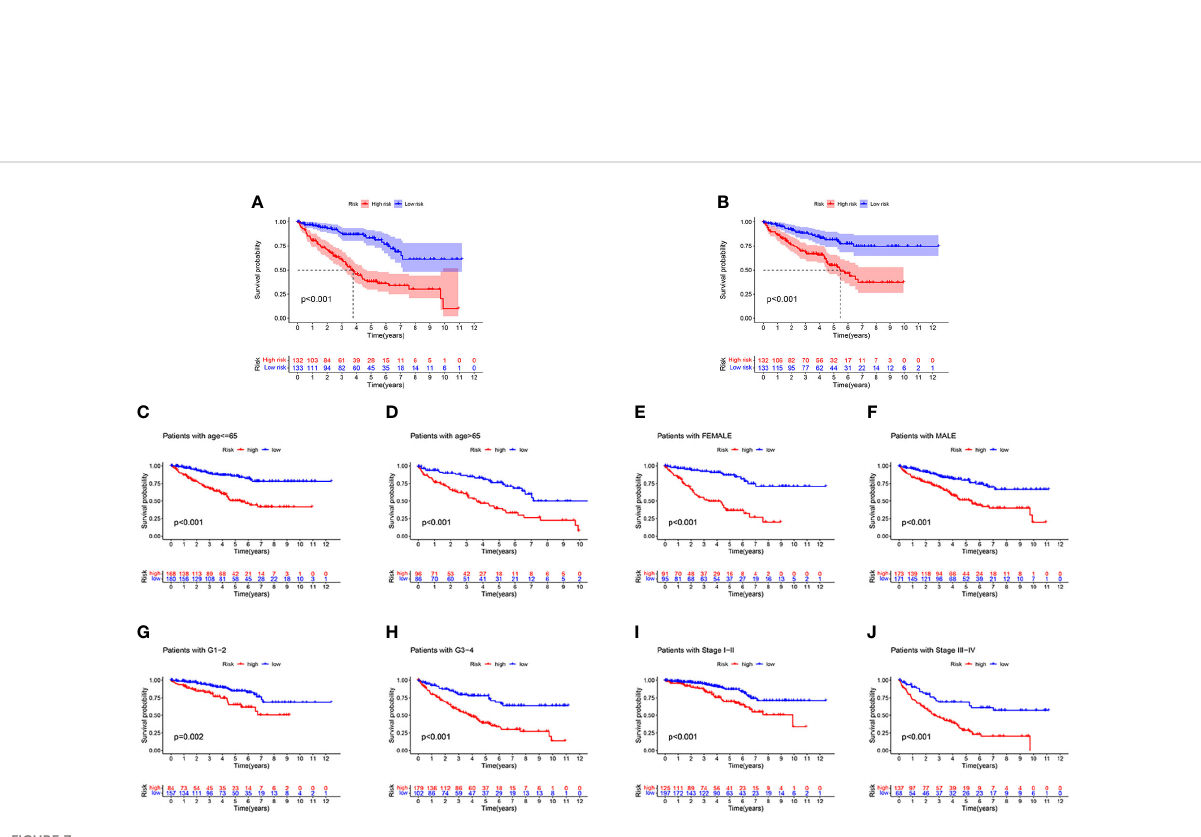
FIGURE 7 The survival analysis. (A, B) The survival analysis between high-risk groups and low risk groups between the training cohort and the validation cohort. (C – J) A more rapid decline in survival in the high-risk group than in the low-risk group, irrespective of age, gender grade and